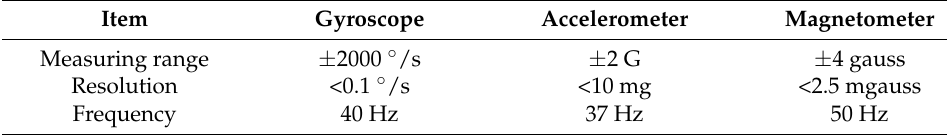
Table 2. Device parameters of AH-100B inertial measurement